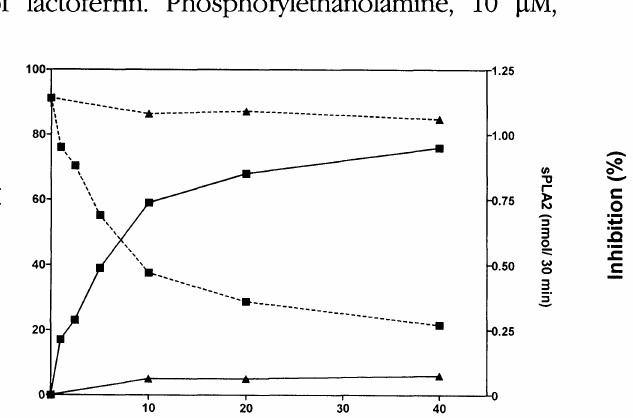
FIG. 1. Inhibition of sPLA2 activity by lactoferrin. Closed squares, solid line--inhibition of sPLA 2 activity using PC:Lyso PC multi- lamellar liposomes as a substrate. Closed squares, interrupted line--as above; expression of sPLA2 in nmol/30 min. Closed tri- angles, solid line--inhibition of sPLA2 activity using PE:Lyso PE multilamellar liposomes as a substrate. Closed triangles, inter- rupted line--as above; expresssion of sPLA2 in nmoles/30 min.